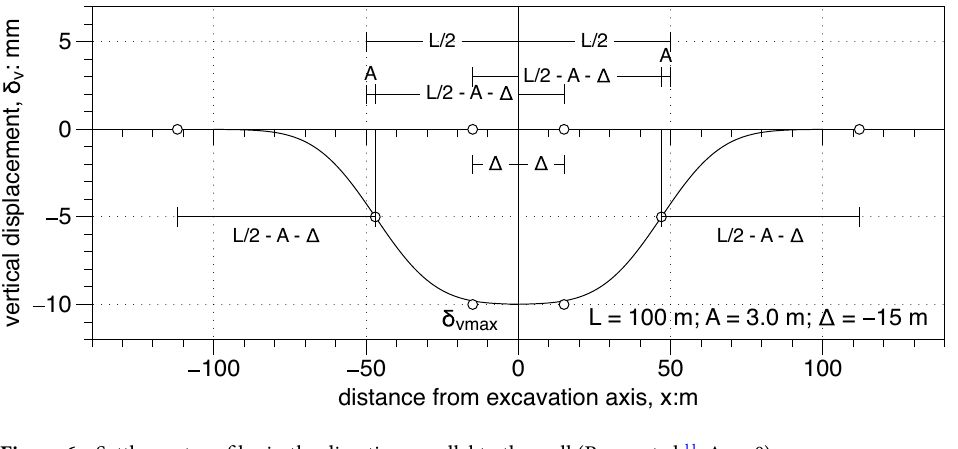
Figure 6. Settlement profiles in the direction parallel to the wall (Russo et al. 11 , � < 0